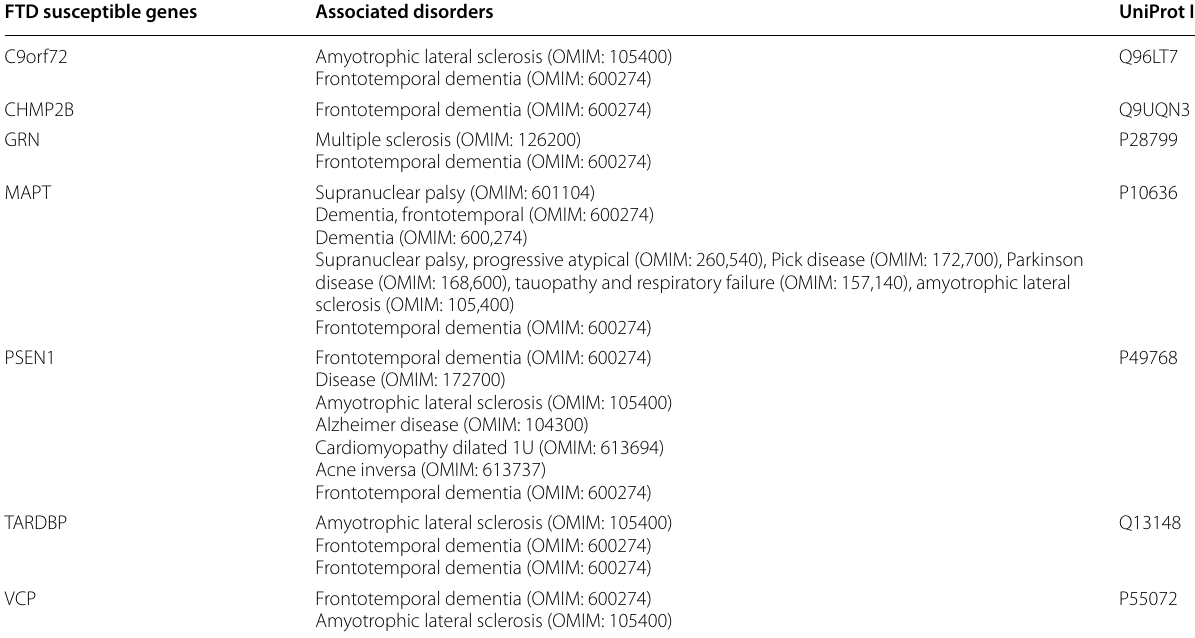
Table 2 Summary of frontotemporal dementia susceptible genes and their associated disorders retrieved from NeuroDNet FTD susceptible genes